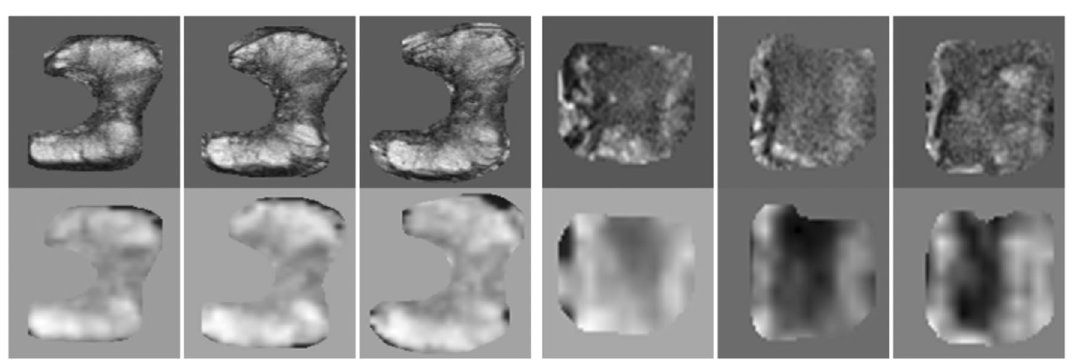
Figure 4. Example of cropped sub-regions with three consecutive slices. (left) PZ with Gleason Grade Group 3. (right) CG with Gleason Grade Group 2. (Upper) T2W. (Lower)